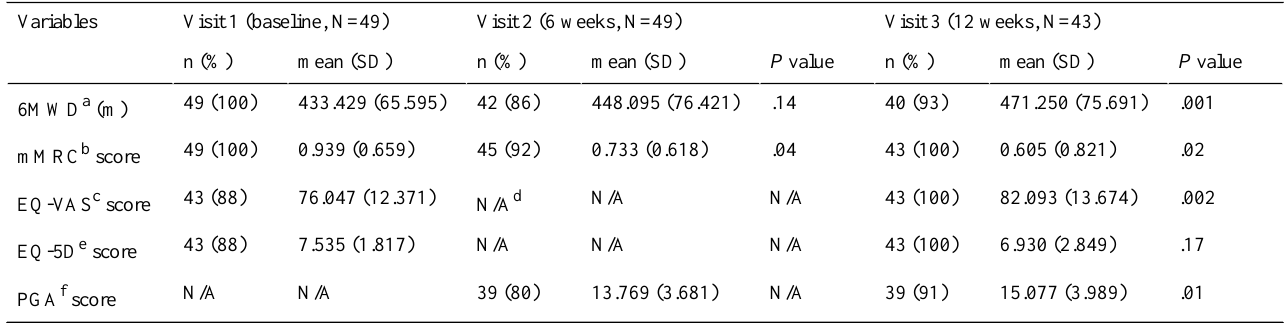
Table 2. Results of all participants’outcome variables according to time point.